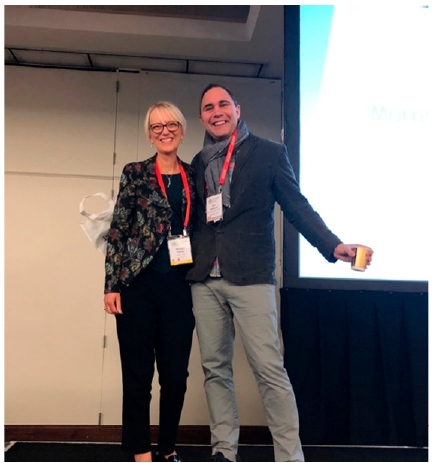
Figure 8. Professor Ben tenOever and A/Prof Merilyn Hibma after the Robert Webster